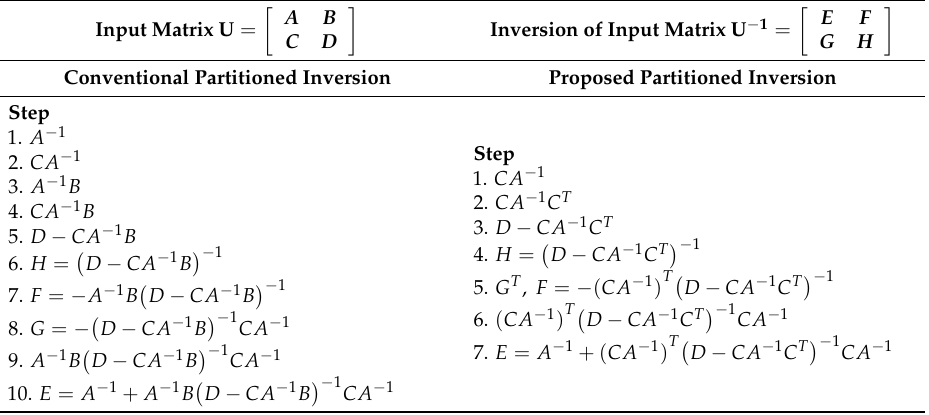
Table 2. Conventional partitioned inversion versus proposed partitioned inversion.